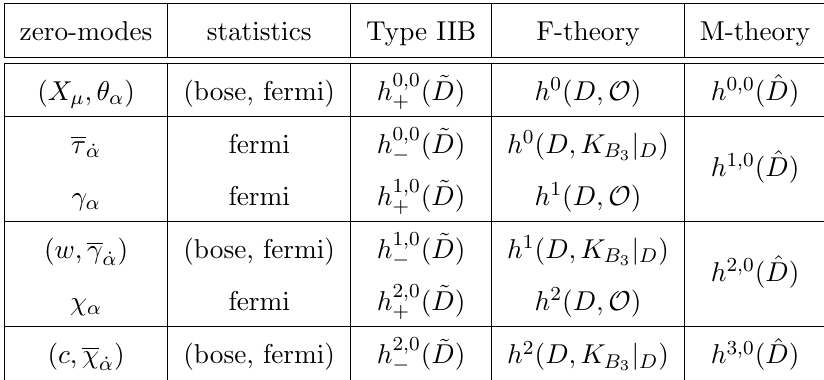
Table 1 . Type IIB and F-theory zero-modes for instantons carrying no instanton (cid:13)ux, as modi(cid:12)ed from [17]. The M5-brane is wrapping the divisor ^ D on an elliptically (cid:12)bered Calabi-Yau 4-fold Y 4 with base B 3 and canonical bundle K B , while the Type IIB D3 instanton is wrapping the divisor 3 ~ D on the Type IIB Calabi-Yau 3-fold X ~ D is the double cover of the divisor D given by the 3 ; projection of ^ D to B 3 . The Type IIB counting applies to so-called O (1) instantons, for which ~ D is invariant under the orientifold involution as a divisor, but not pointwise. The last three columns give the homology classes counting the respective types of modes in absence of instanton (cid:13)ux. In the Type IIB case, the homology is split into orientifold even and orientifold odd sectors [17]. The modes counted by h 2 ; 0 ( ~ D ) may be lifted by instanton (cid:13)ux [8]. The counting in the fourth column (cid:6) follows from a Leray sequence argument and is valid only if ^ D is smooth